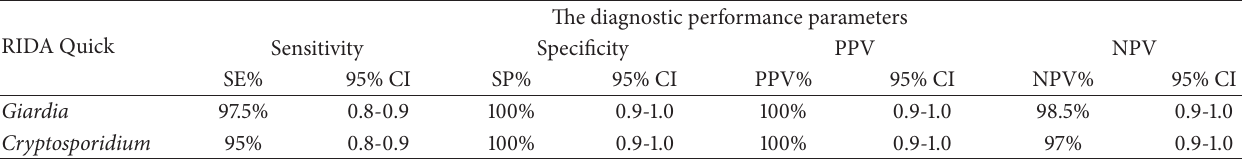
Table 3: The diagnostic performance of the two rapid